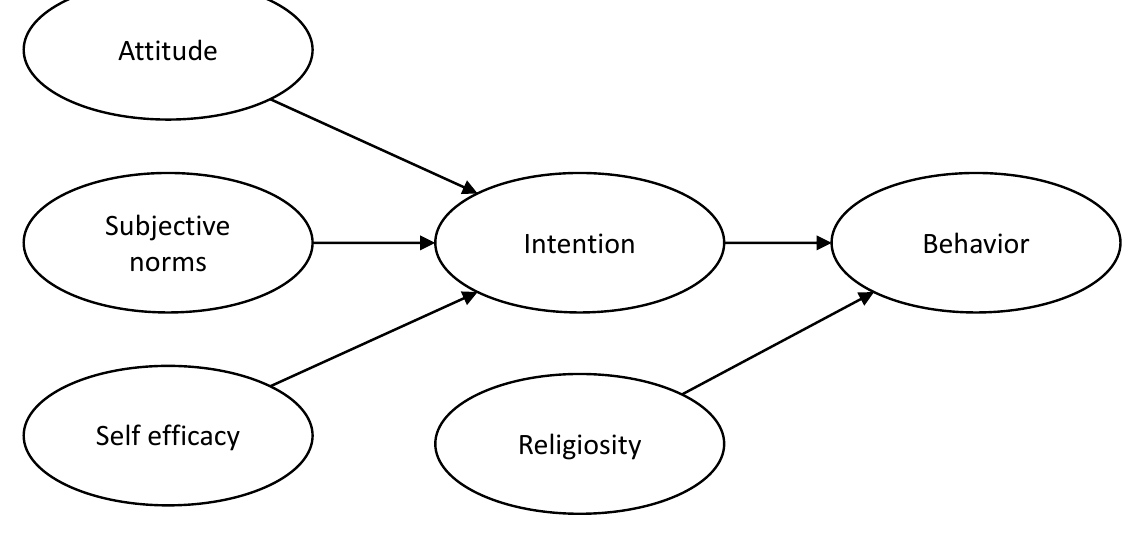
Figure 2. Research